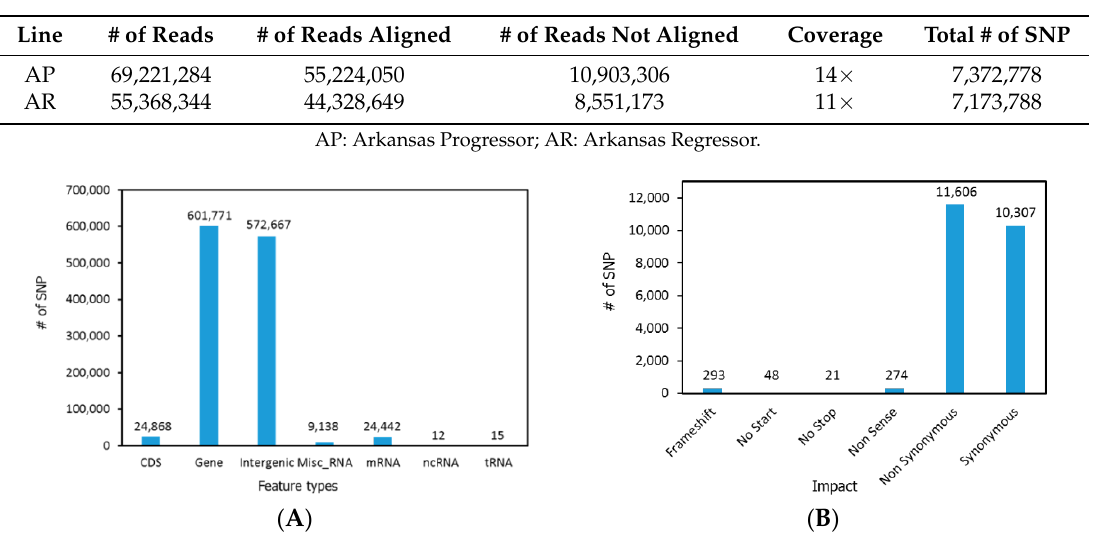
Table 2. Data from HiSeq and sequence assembly.